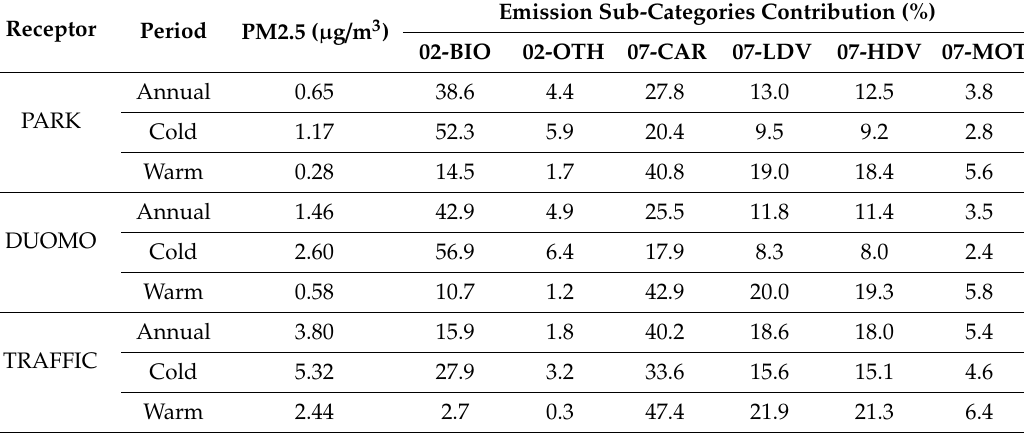
Table 1. Total annual and seasonal average contributions to PM2.5 ambient levels and percentage contributions of emission sources in the LOCAL area at the three urban receptors. (02-BIO: Residential and commercial heating-Biomass burning; 02-OTH: Residential and commercial heating-Fossil fuels burning; 07-CAR: Road tra ffi c-Passenger cars; 07-LDV: Road tra ffi c-Light Duty Vehicles;